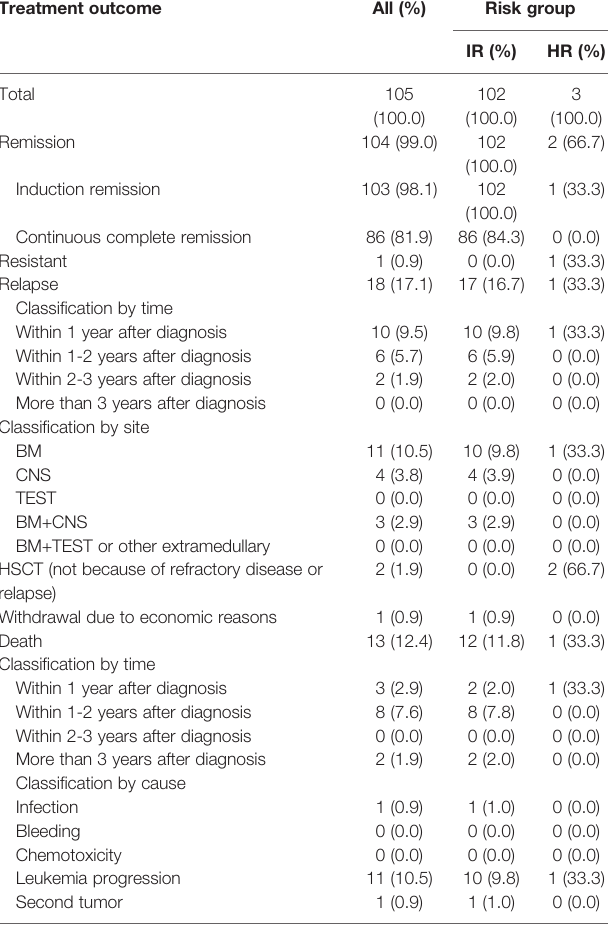
TABLE 2 | Ef fi cacy evaluation of 105 children with